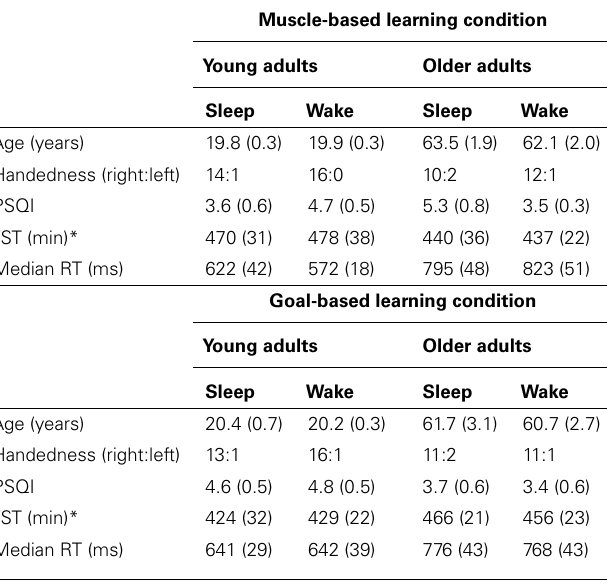
Table 1 | Descriptive data for each group (means followed by standard error in